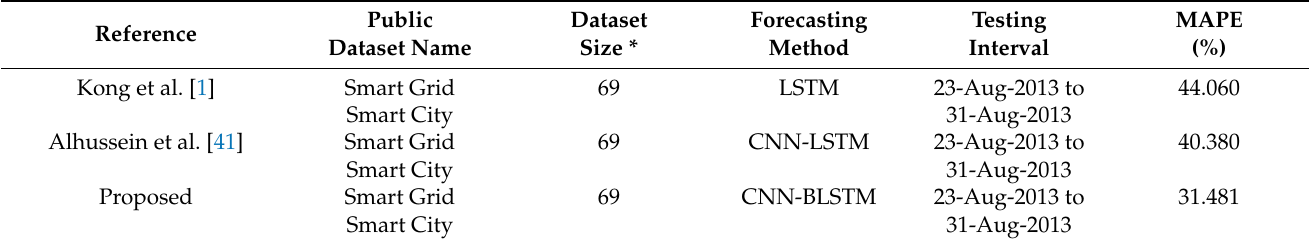
Table 4. Benchmarking of different studies using mean absolute percentage error (MAPE) criterion.